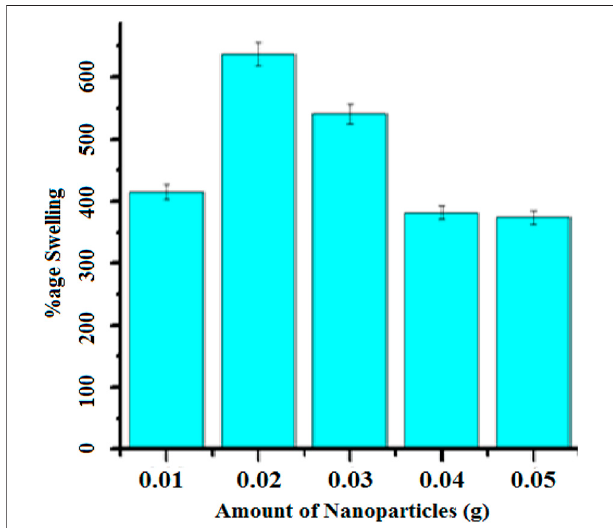
FIGURE 7 | Impact of amount of nanoparticles on Ps of Kg-cl-poly (AA)- Cu-Ni bionanocomposite.